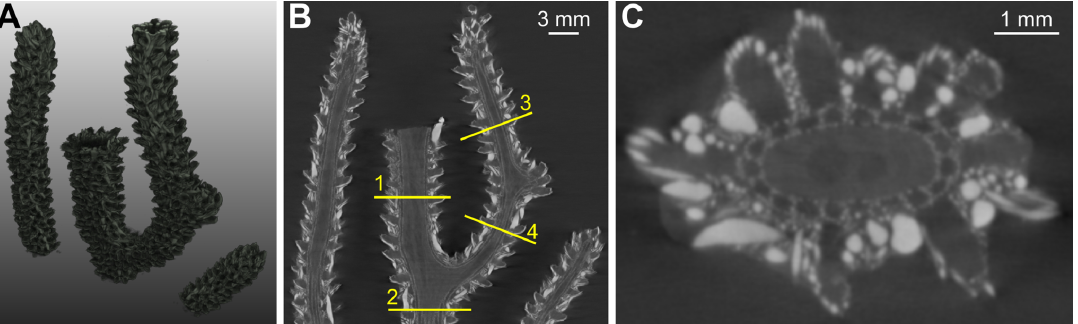
Figure 5. S3 dataset. (A) volume rendering, (B) example of longitudinal slice, (C) axial slice corresponding to the lowest initialization plane. The lines superimposed onto the image represent the location of the initialization